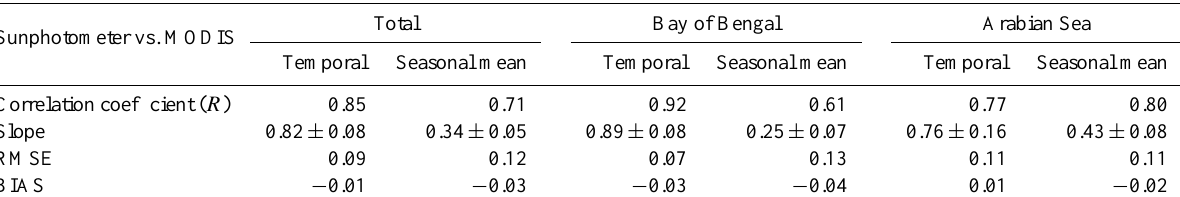
Table 4. Comparison of linear regression statistics between the ship-based remote sensing measured and MODIS retrieved AODs for the temporal (sampled at the right days along the track) and seasonal mean (ICARB period mean geographical distribution sampled along the ship track) during ICARB cruise period.